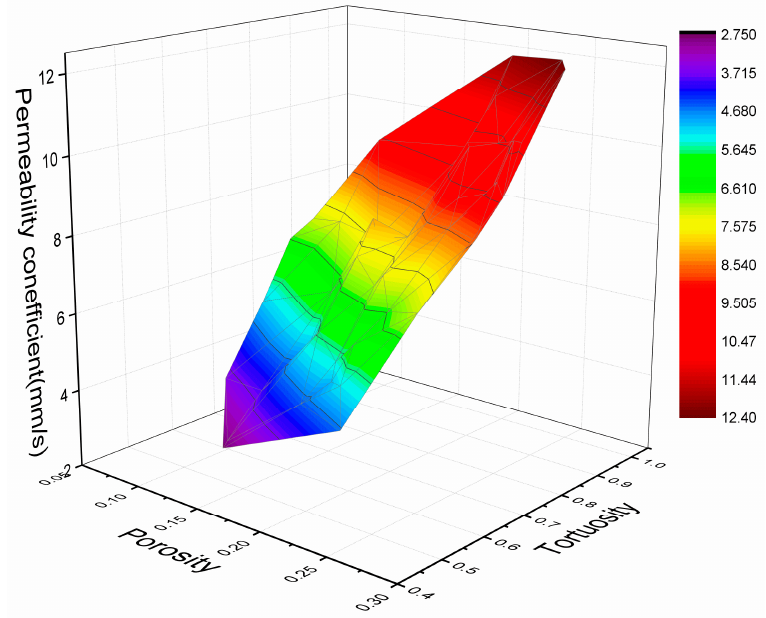
Figure 12. Influence of porosity and tortuosity on permeability coefficient.